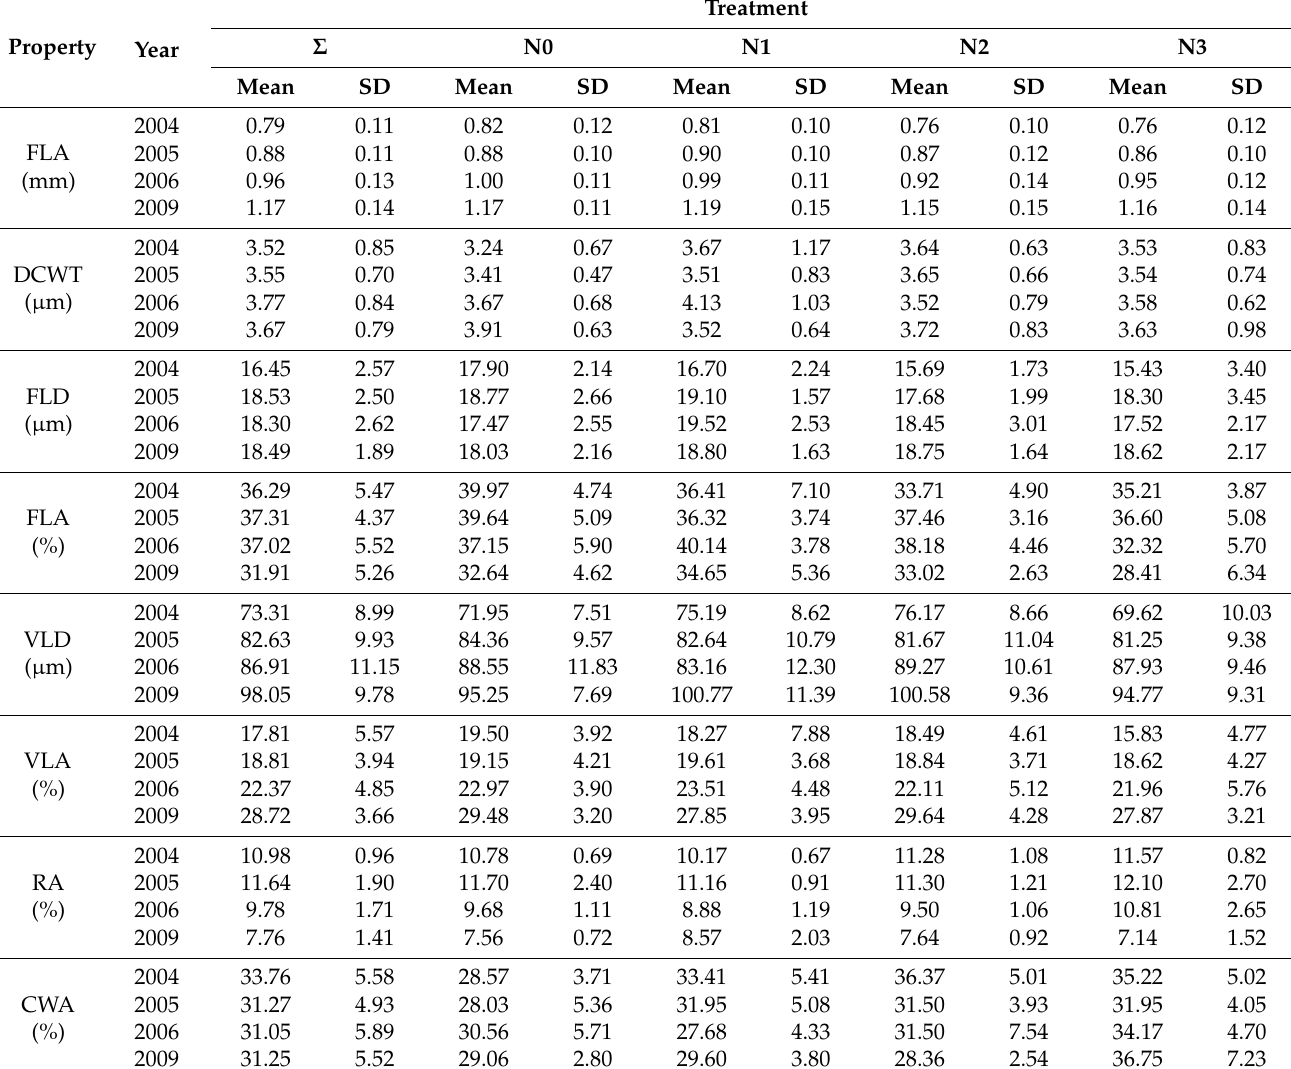
Table 1. Descriptive statistics for different years of the anatomical properties of the juvenile wood of the clone ‘Villafranca’. Measurements per group of each treatment in a year are n = 160 (fibre